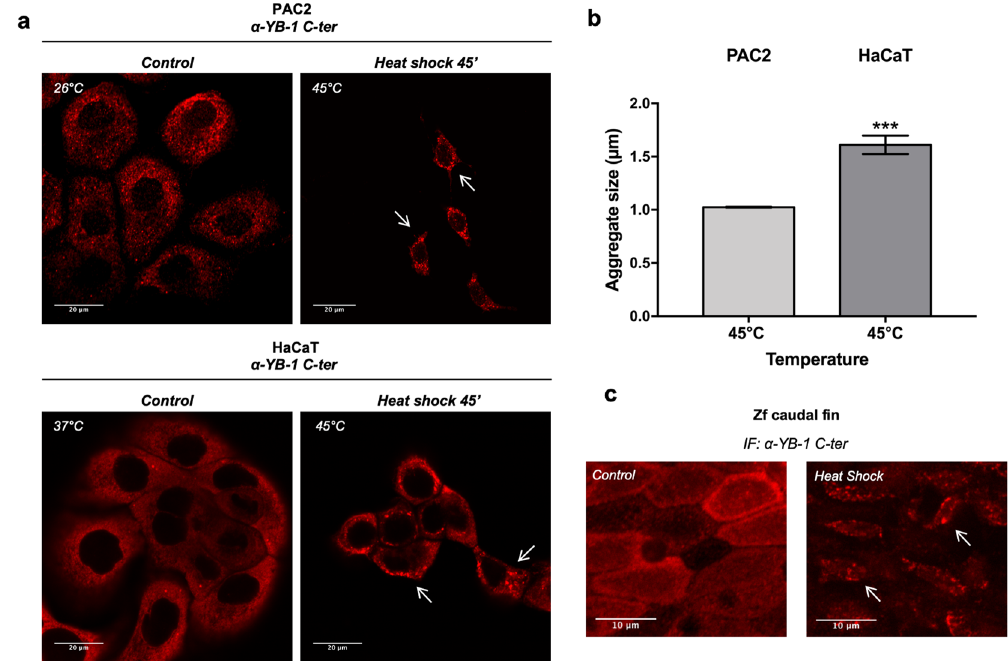
Figure 3. Heat shock promotes assembly of YB-1 positive aggregates in zebrafish and mammalian cells. (a) confocal immunofluorescence of PAC2 cells ( upper panels ) and HaCaT cells ( lower panels ) stained with human α -YB-1 C- ter antibody (red); some YB-1 aggregates are indicated by arrows; ( b) quantification of YB-1 aggregate dimensions after heat shock at 45 °C for 45 ′ in PAC2 and HaCaT cells (unpaired t-test with Welch’s correction * p = 0.007, see also Table S1); ( c ) confocal immunofluorescence of adult zebrafish caudal fins at 26 °C (control) and after heat shock at 45 °C, stained with human α -YB-1 C-ter antibody. YB-1 aggregates are indicated by